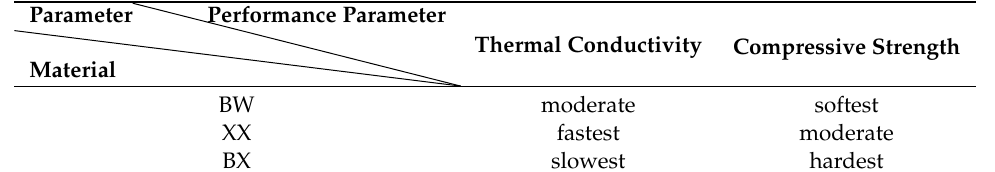
Table 14. Material performance parameter comparison table.